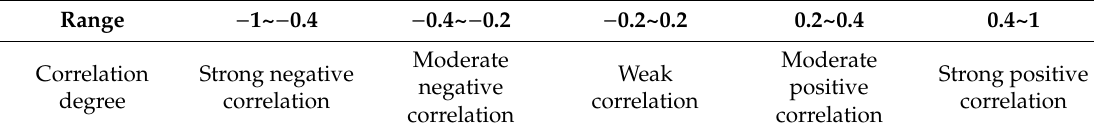
Table 3. Range of Pearson correlation coe ffi cients and correlation degrees.